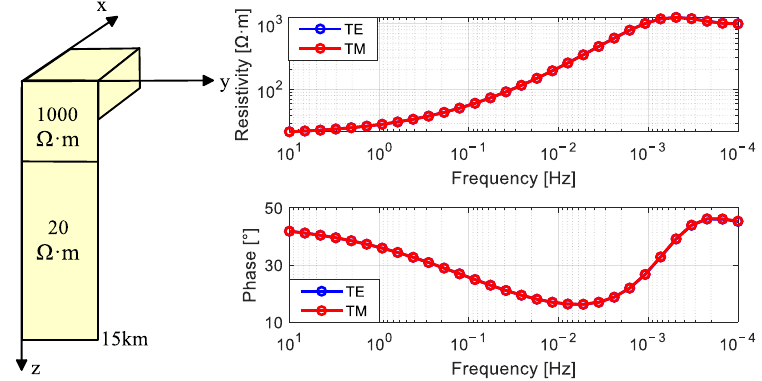
Figure 3. Isotropic layer model, apparent resistivity, and phase tensor results.